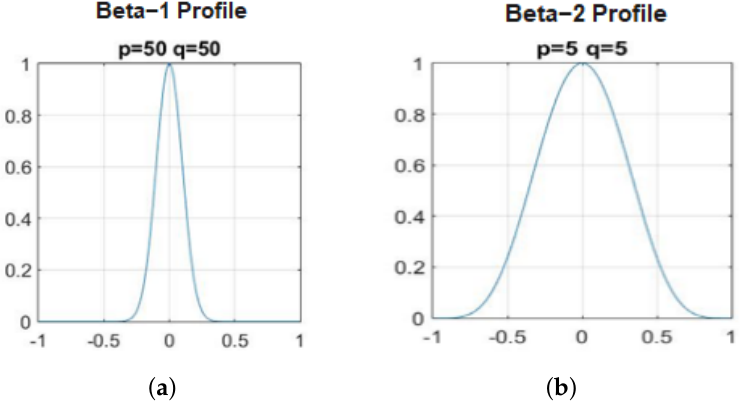
Figure 3. Beta profiles , respectively ( a ) Beta-1 and ( b ) Beta-2